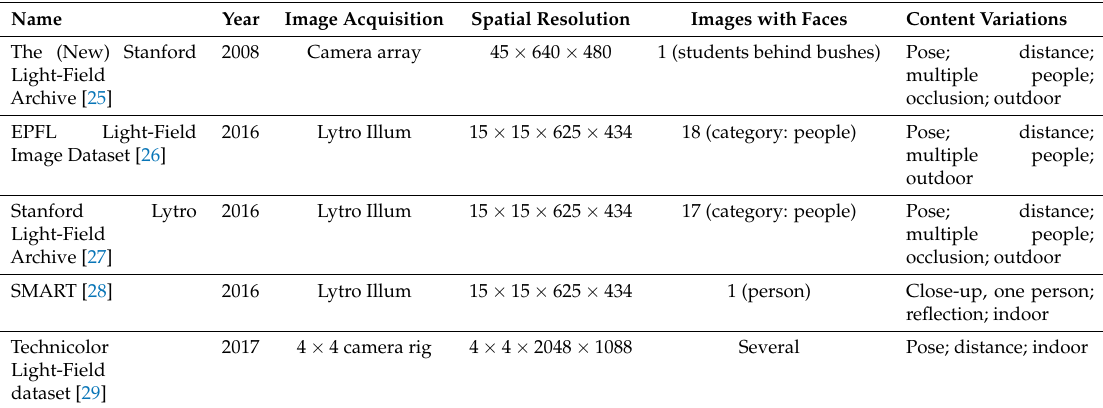
Table 1. General-purpose light-field databases that include facial images.